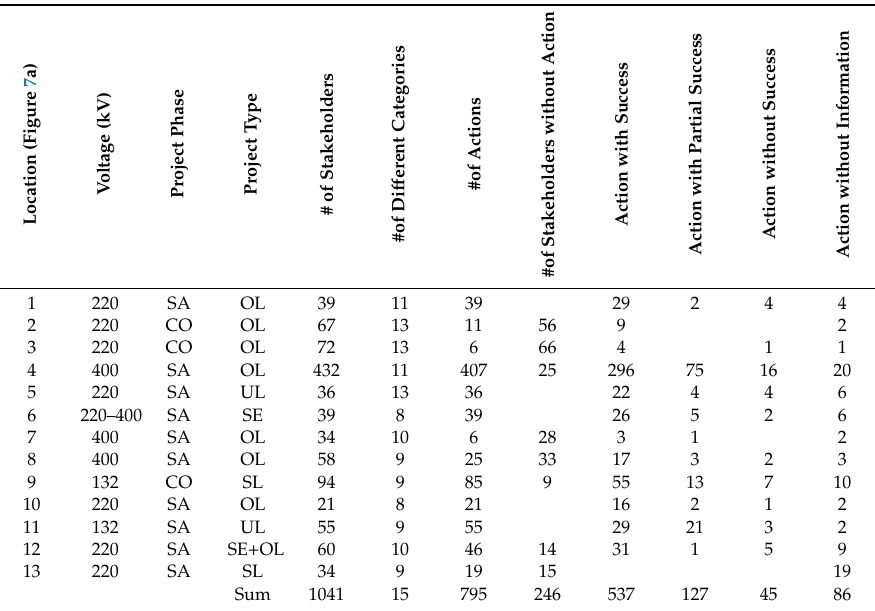
Table1. Listofprojectsanalyzed, projectphasedetailingthesetofregisteredstakeholdersandtheactions carried out with them. The legend for project phase is SA = Studying alternatives; CO = Construction. The legend for project type is OL = Overhead line; UL = Underground line; SE = Substation; SL = Submarine line. The last row expresses the sum of the topics written in the heading, except for the column ‘# of di ff erent Categories’, which expresses the number of di ff erent categories registered in the 13